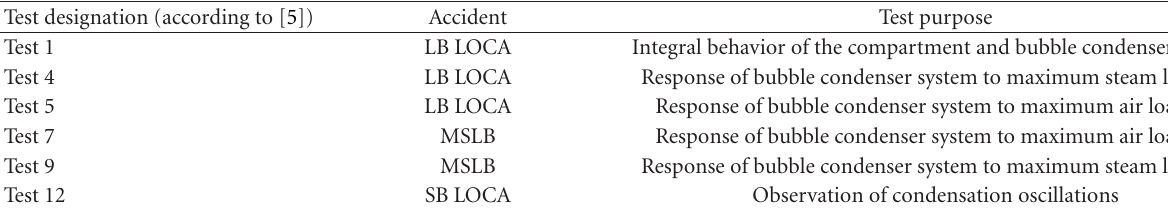
Figure 4: High-pressure system. Table 3: Test